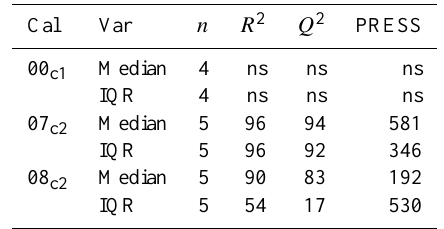
Table 3. Partial least square regression (PLS) results indicating the goodness of fit for the prediction of median and the interquartile range (IQR) of headwater total organic carbon (TOC) concentration (mgL − 1 ) . Cal is calibrated and 00, 07 and 08 refer to sampling year (2000, 2007 and 2008) of catchment (number = n ). PRESS is the prediction error sum of squares.